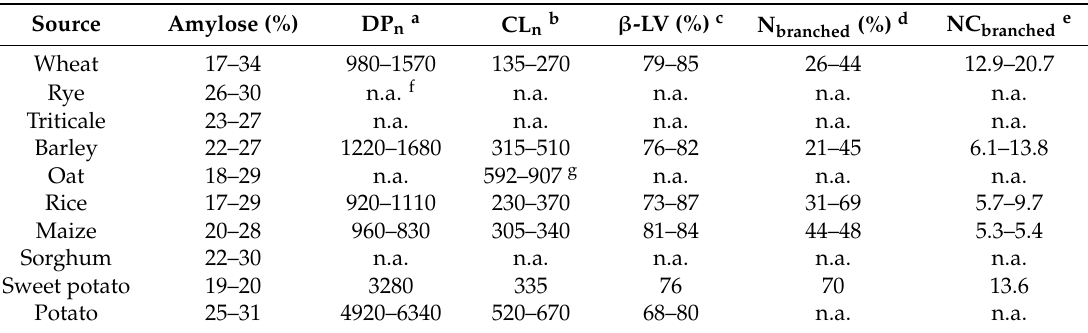
Table 1. Amylose content and structure in selected